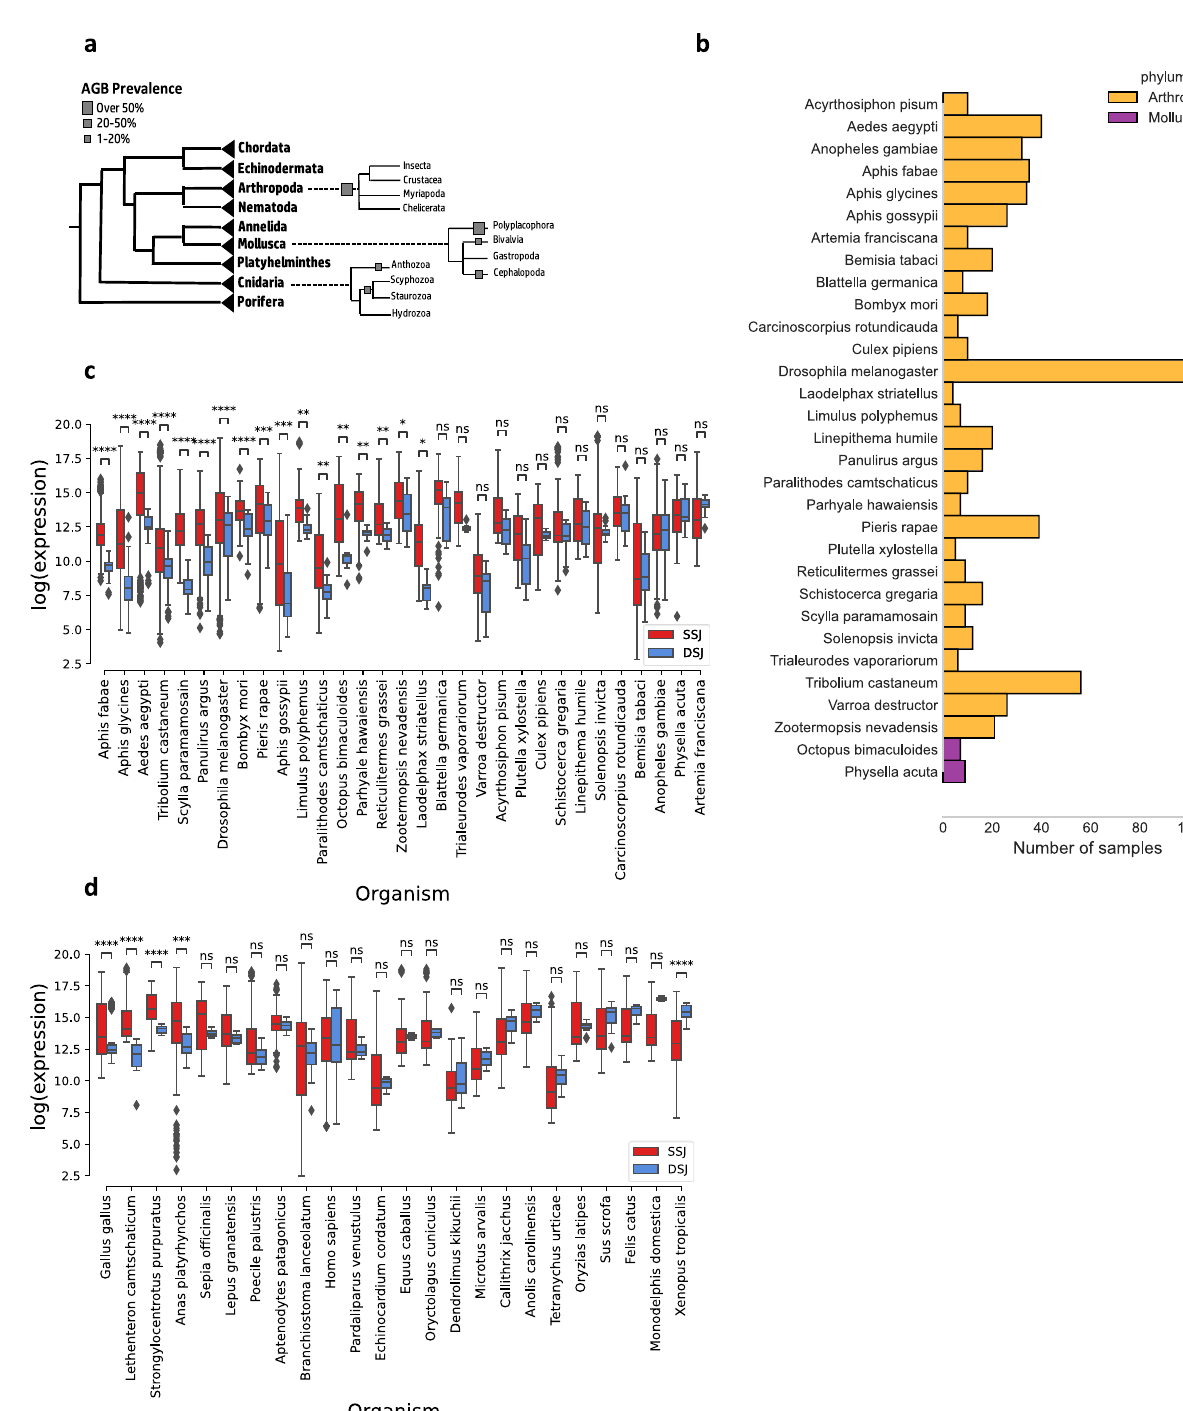
Fig. 5 Signi fi cantly reduced DSJ expression in species with alternating mtDNA gene blocks organization. a Percentage of different species with alternating gene blocks organization within each phylum. b Number of analyzed RNA-seq samples per species for arthropods with alternating gene block organization. c , d Boxplot comparisons of log normalized expression between different strand junctions (DSJ) and same strand junctions (SSJ) in species with ( c ) or without ( d ) alternating gene block mtDNA organization. P value ranges are marked by asterisks. The p values were calculated using a two-sided Mann – Whitney test, corrected for multiple testing using the Bonferroni correction. * 0.01 < p ≤ 0.05, ** 0.001 ≤ p < 0.01, *** 0.0001< p ≤ 0.001, **** p ≤ 0.0001. Each box extends from the 25th to the 75th percentiles, whiskers denote values within 1.5 interquartile range of the percentiles. Dots denote outliers outside of the mentioned ranges. See also Supplementary Data S10 for raw data (https:// fi gshare.com/projects/Shtolz_2022_mtDNA_ evolutionary_rearrangements/156008).